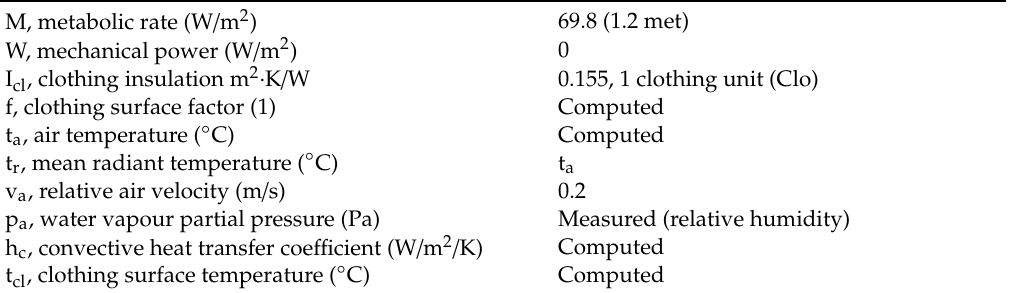
Table 1. Parameter values used in the computations of PMV and PPD.